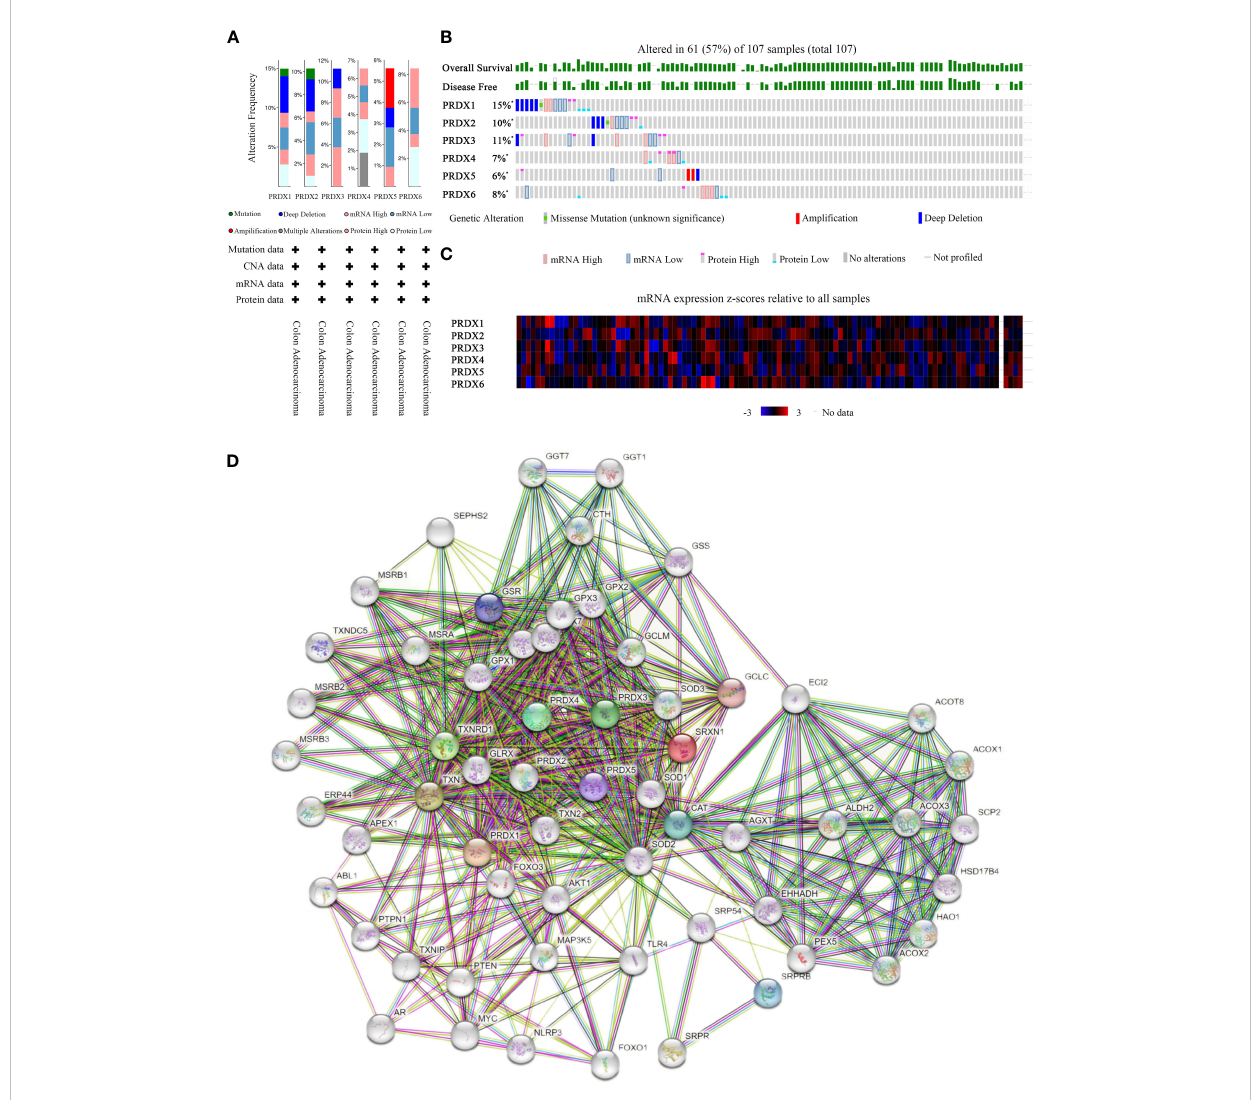
FIGURE 8 Mutation and expression analysis of PRDX gene in COAD (cBioPortal and STRING). (A, B) Summary of alterations in different expressed PRDXs in COAD. PRDXs were altered in 61 of the 107 COAD patient samples, accounting for 57%. (C) Heatmap showing mRNA expression z-scores relative to